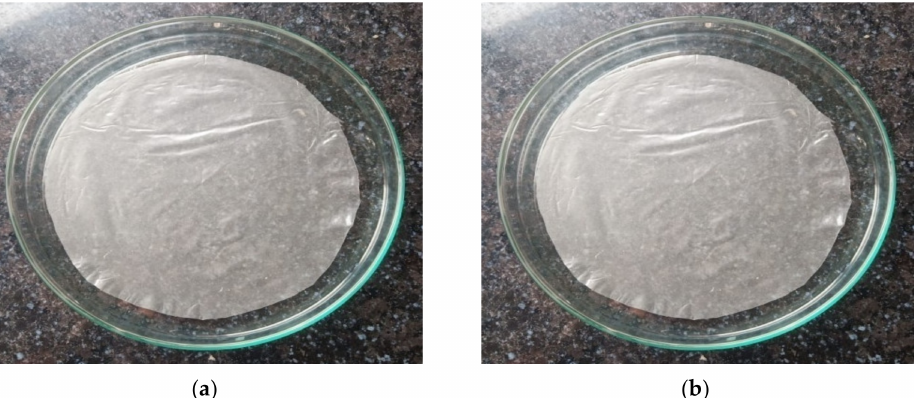
Figure 3. ( a , b ) Different proso millet starch films. ( a ) native proso millet starch film, ( b ) proso millet starch–k-carrageenan